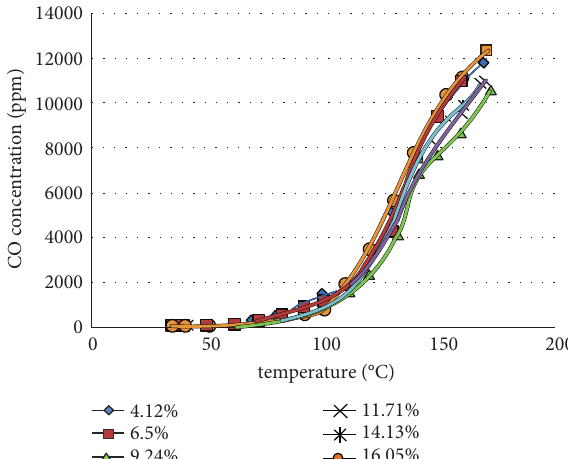
Figure 14: Evolution of CO concentration, as an index of coal spontaneous combustion, for samples with different moisture content in the whole temperature range investigated.